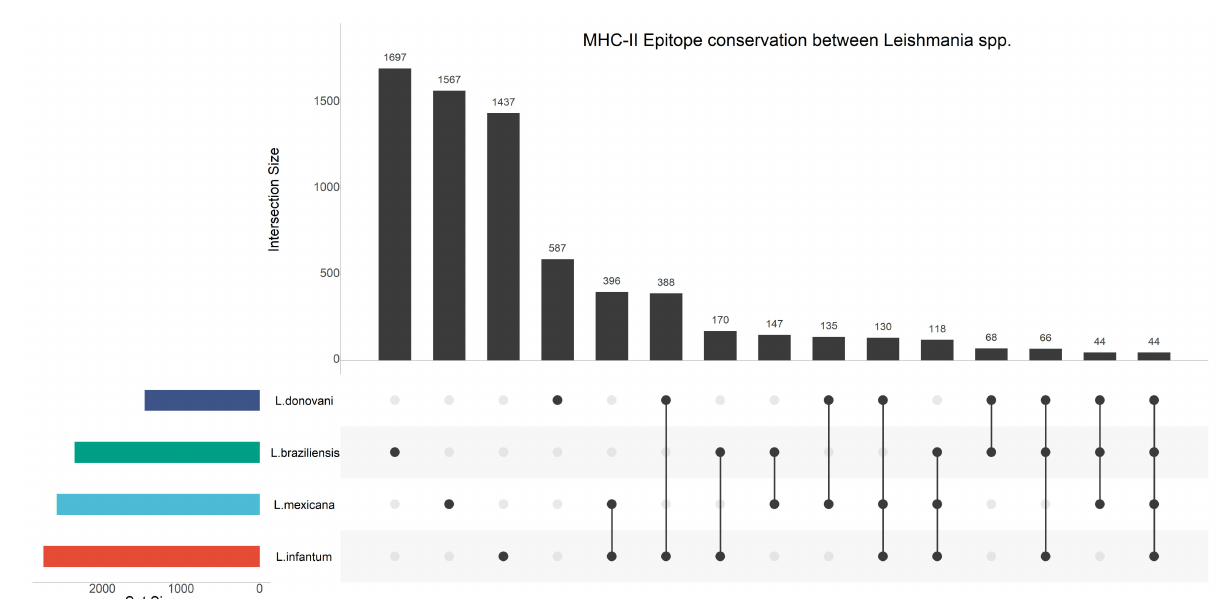
Figure 3. Upset Plot of strong-binding epitopes that are 1) unique to protection-associated alleles and 2) conserved across two major VL- ( L. infantum and L. donovani ) and two major CL-causing Leishmania species ( L. braziliensis and L. mexicana ). The set size denotes the total number of strong-binding epitopes predicted for each species, while the intersection size denotes the number of strong-binding epitopes shared across the species.